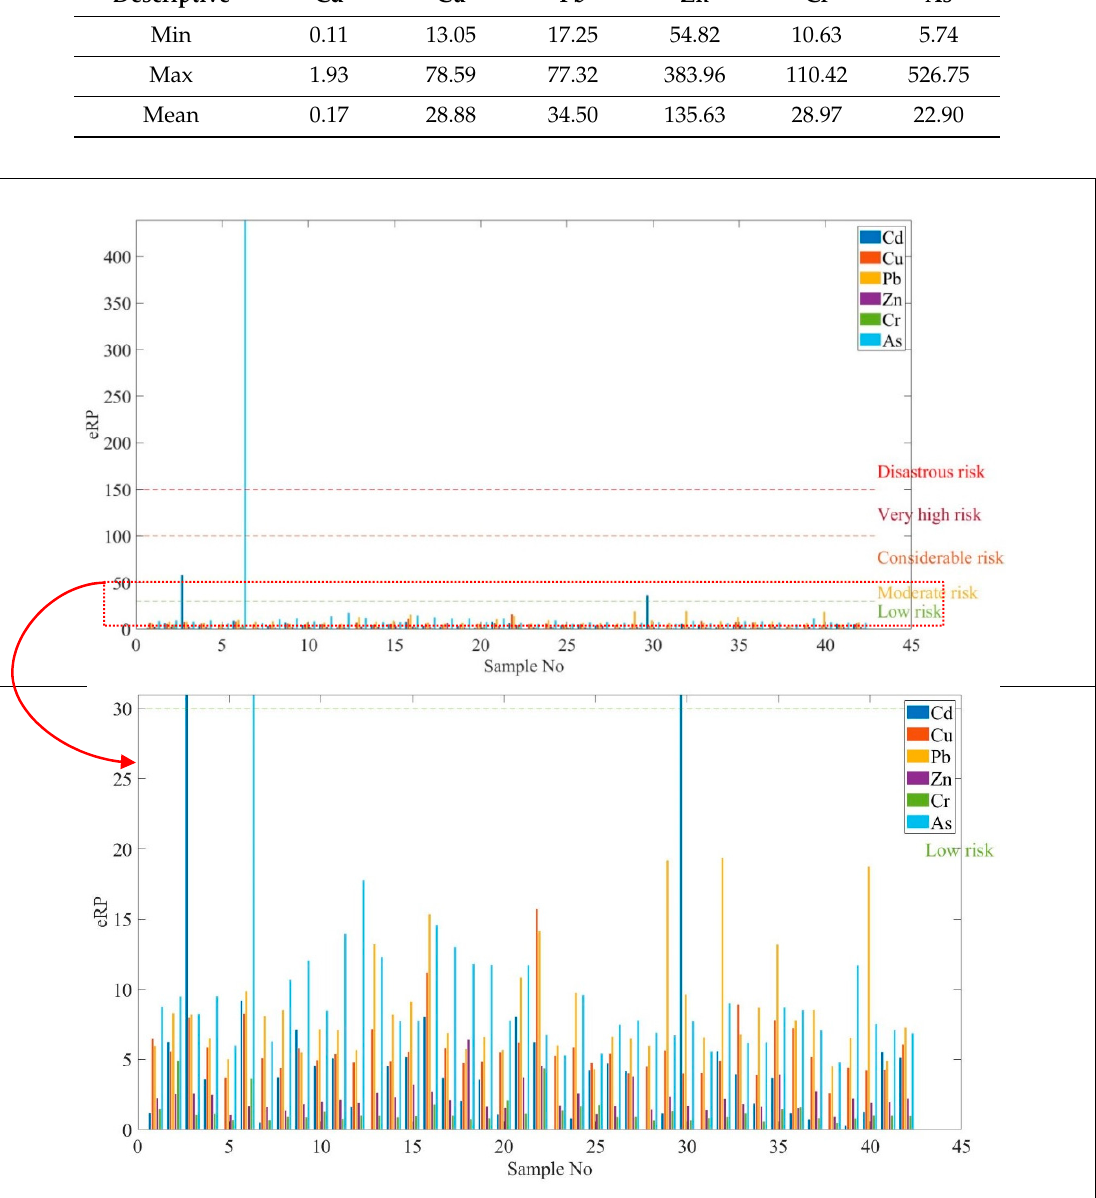
Figure 9. Potential ecological risk index of single element ( eRP i )